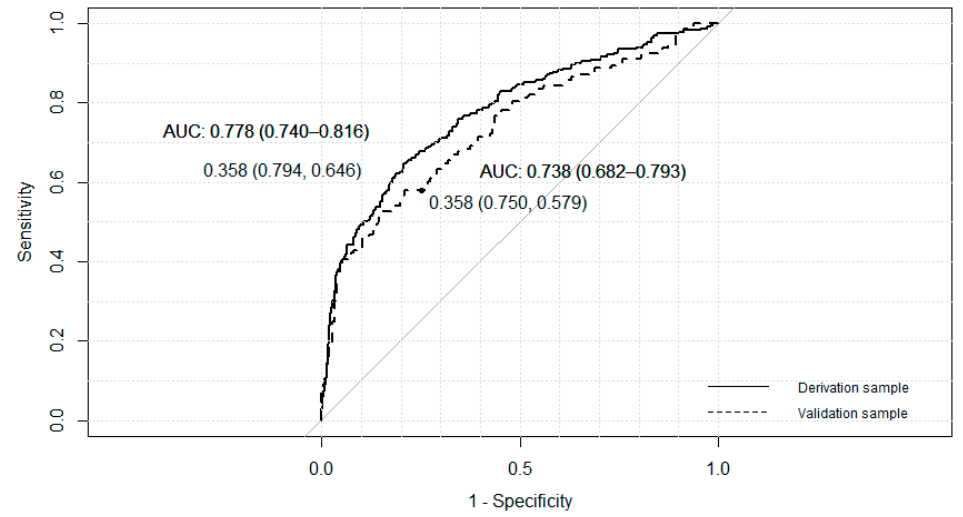
= Area Under the Curve.